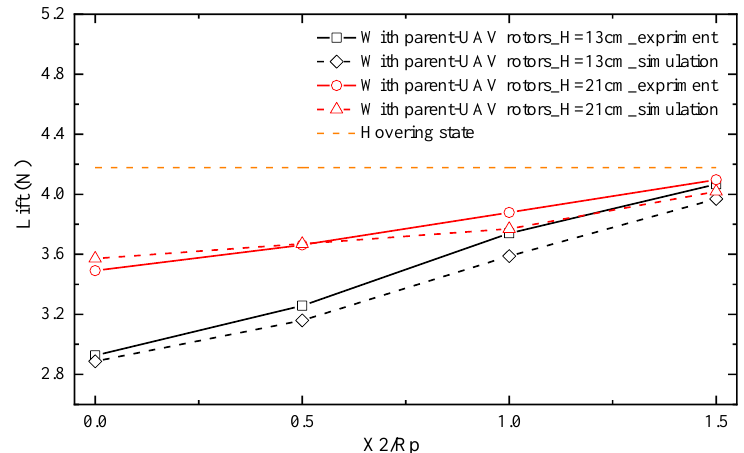
Figure 17. The lift of child UAV in rotor-outside transition area.